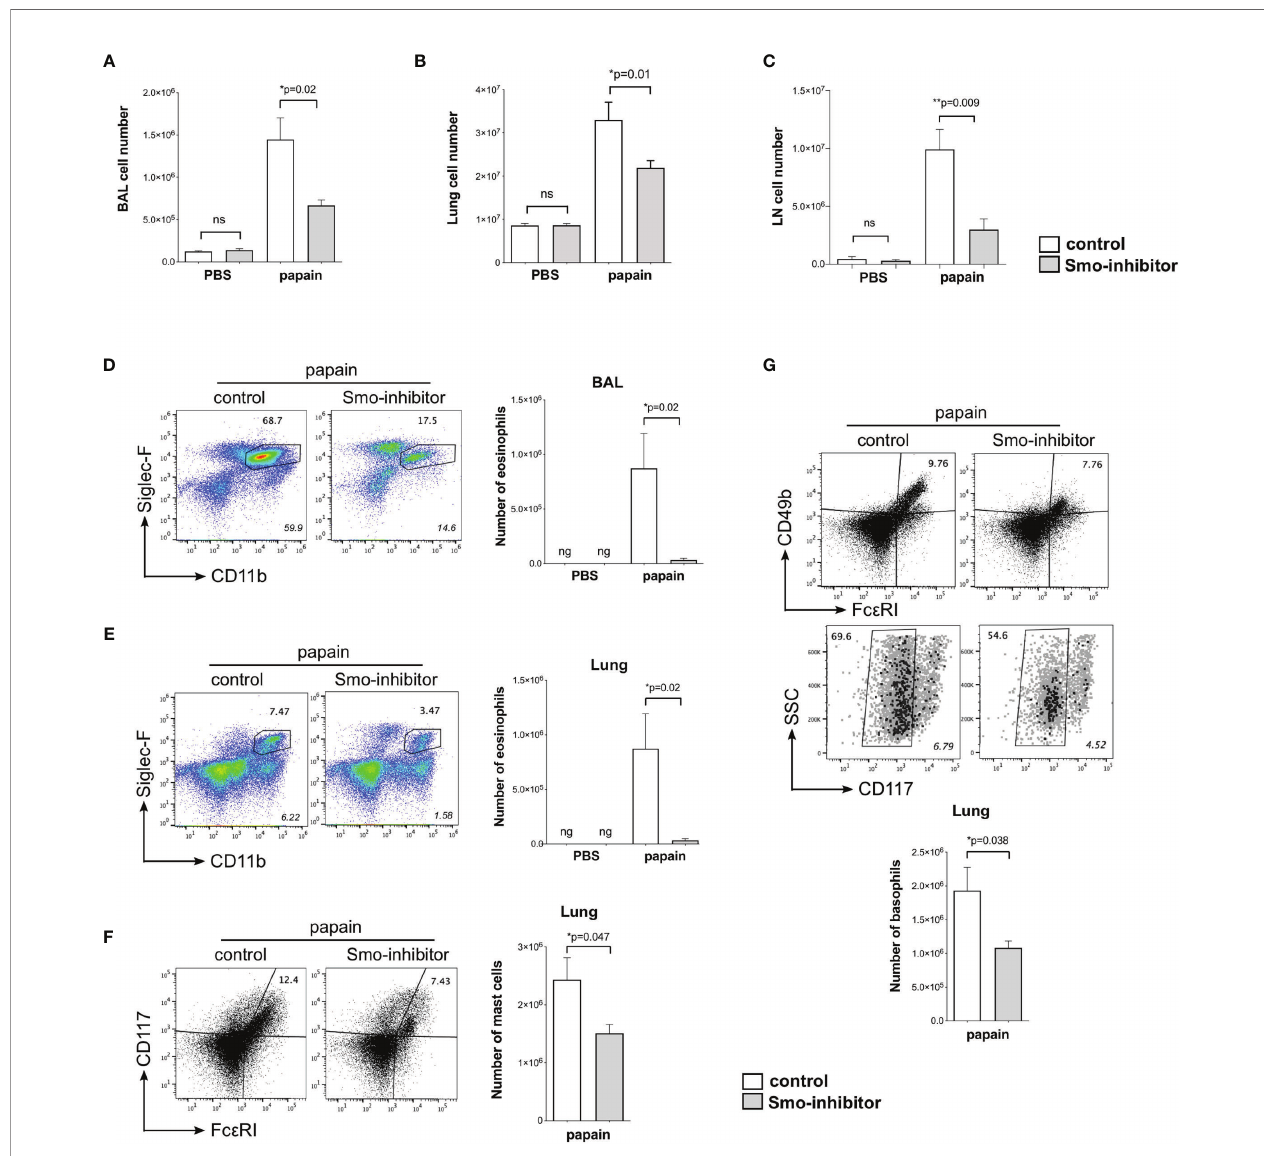
FIGURE 2 | Reduction of in fl ammatory response upon allergic sensitization by systemic smoothened-inhibitor treatment. Mice underwent the PBS or papain protocol and smoothened inhibitor or control treatment as in Figure 1A . (A – C) Bar charts: mean ± SEM number of cells recovered from (A) BAL, (B) lung, and (C) mLN under different treatments. (D,E) Analysis of eosinophils, giving percentage of eosinophils, from (D) BAL and (E) lung from control and Smo-inhibitor conditions under papain treatment. Italicized numbers indicate percentage of eosinophils in the live gate. Bar chart: mean ± SEM number of eosinophils under different treatments. (F) Flow cytometry: cells from lung stained against CD117 and Fc e RI, showing the percentage of CD117 + Fc e RI + (mast cells) from control and Smo-inhibitor papain-treated groups. Bar chart: mean ± SEM number of mast cells. (G) Flow cytometry: cells from lung of papain-protocol control and Smo-inhibitor groups to identify basophils (CD49b + Fc e RI + CD117 - ). Non-italicized numbers on plots give the percentage of cells in the regions shown, and italicized numbers indicate percentage of basophils in the live gate. Bar chart: mean ± SEM number of basophils. For (A, B, D – G) : PBS groups n = 5 and papain-treated groups n = 6; for (C) PBS groups and papain-Smo-inhibitor n = 5; papain-control group n = 6; ng, negligible; *p < 0.05, **p < 0.01, unpaired Student ’ s t-test. Data shown are from a representative experiment, and n numbers represent individual mice in the representative experiment shown. n.s., not signi fi